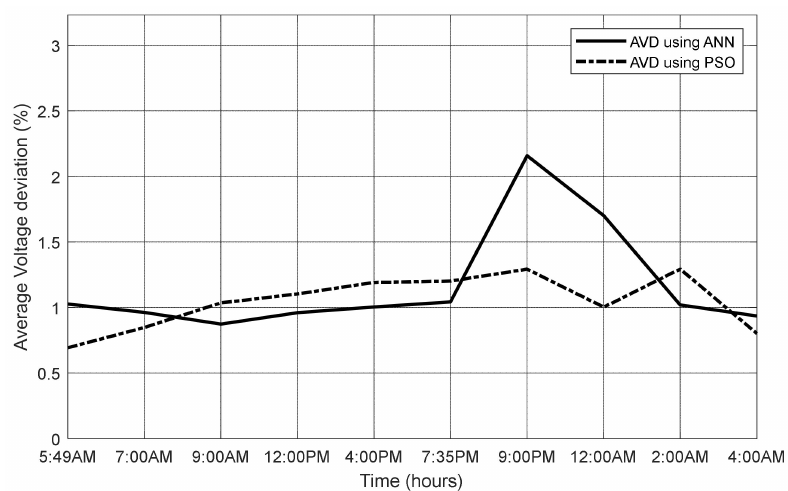
Figure 7. AVD using ANN control on two STATCOMs at TPV2 and TPV3.